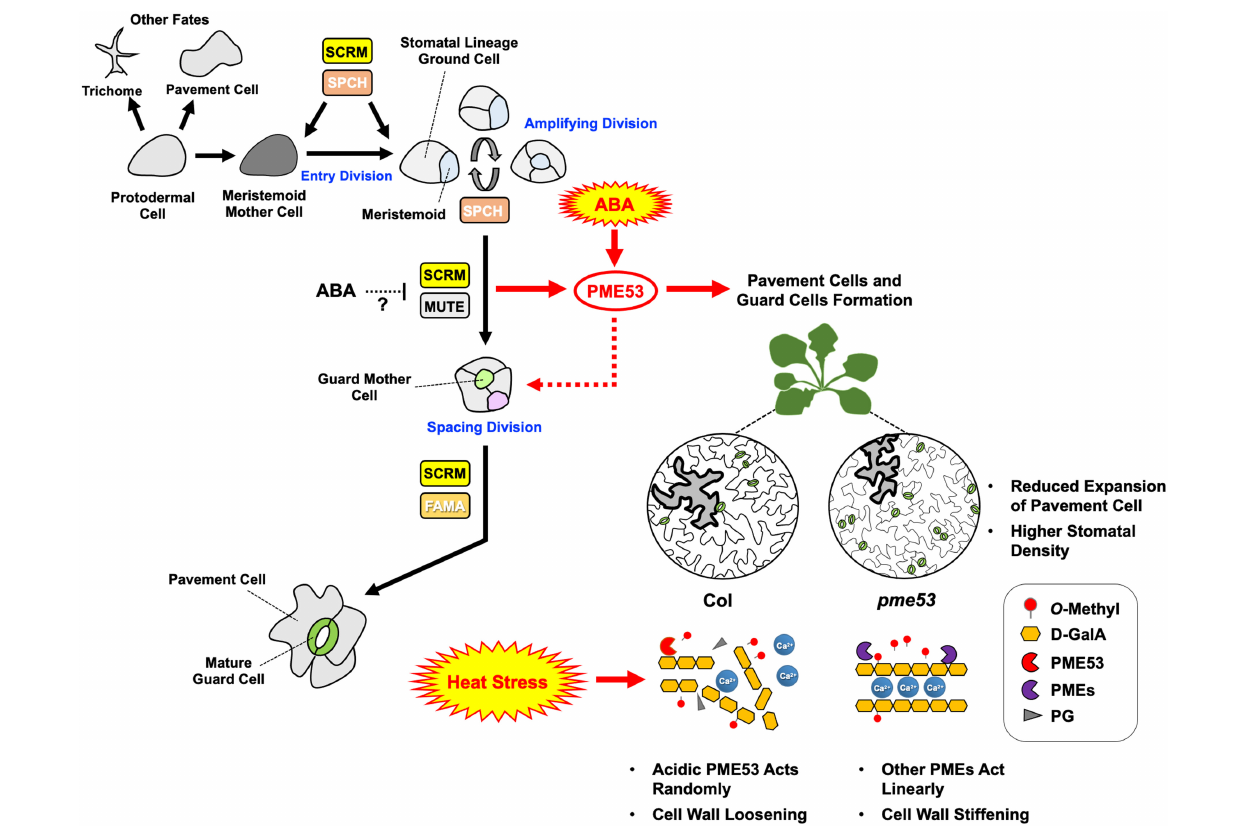
FIGURE 11 | Arabidopsis PME53 , a guard-cell specific gene, involves in stomatal development and stress response. The stomatal lineage consists of five major cell types: meristemoid mother cells (MMCs), meristemoids, stomatal lineage ground cells (SLGCs), guard mother cells (GMCs), and guard cells (GCs). GCs initiate from MMCs which are derived from a subset of protodermal cells. MMCs carry out asymmetric entry divisions to produce smaller meristemoids and larger SLGCs. Meristemoids undergo one to three rounds of asymmetric amplifying divisions before differentiating into GMCs. GMCs can undergo symmetric division to form a pair of GCs. Stomatal development is regulated by a group of bHLH transcription factors, including SPCH, MUTE, and FAMA, and the interacting factor SCRM, which are critical to mediate guard cell differentiation at different steps of stomatal lineage in Arabidopsis (Davies and Bergmann, 2014). PME53 may involve in stomatal cell lineage through the regulation of SCRM and MUTE transcription factors. ABA might be involved in stomatal development by repressing SPCH and MUTE. Whether the heterodimerization between SCRM and MUTE is involved in ABA-regulated, still need to be investigated. ABA may act upstream of PME53 to regulate the function of PME53: a null mutation in PME53 results in a significantly increased number of stomata as well as affected stomatal movement in response to heat as compared with the Col. During non-lethal heat stress, acidic PME53 acts randomly on pectin. Absence of PME53 may be led to active other PMEs which work on linearly promoting the formation of Ca 2 + mediated cross-linking to confer the less heat-sensitive phenotype in pme53 . Black arrows indicate that stomatal lineage signaling pathways have been thoroughly studied. Red arrows represent the new findings in this study, indicating that PME activity is governed by a network of signaling pathways related to ABA regulation and heat stress